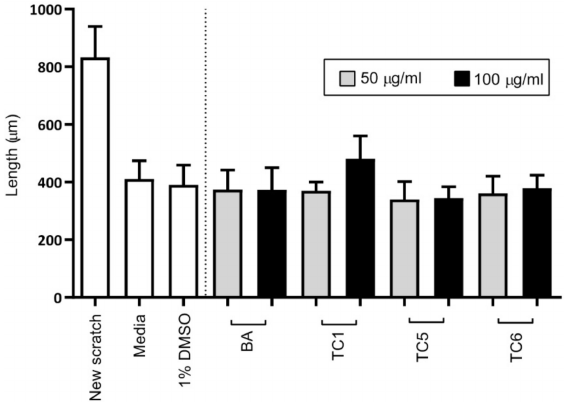
Figure 5. Wound healing assay in Balb / c 3T3 cells treated with two concentrations (50 and 100 µ g / mL) of MeOH extracts (TC1: root, TC5: cell suspension and TC6: callus) and bryonolic acid (BA) compared with 1% v / v DMSO treatment. The bar graph and error bars represent the mean and standard deviation of the length ( µ m) from the